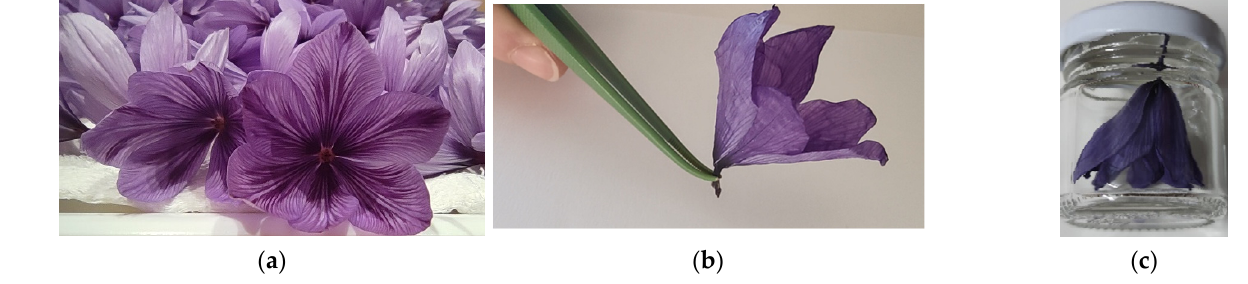
Figure 10. Fresh flowers of Crocus sativus L. free of stamens and stigmas ( a ); flower dried in 3D configuration ( b ); 3D dried flower conserved in a glass jar ( c ).